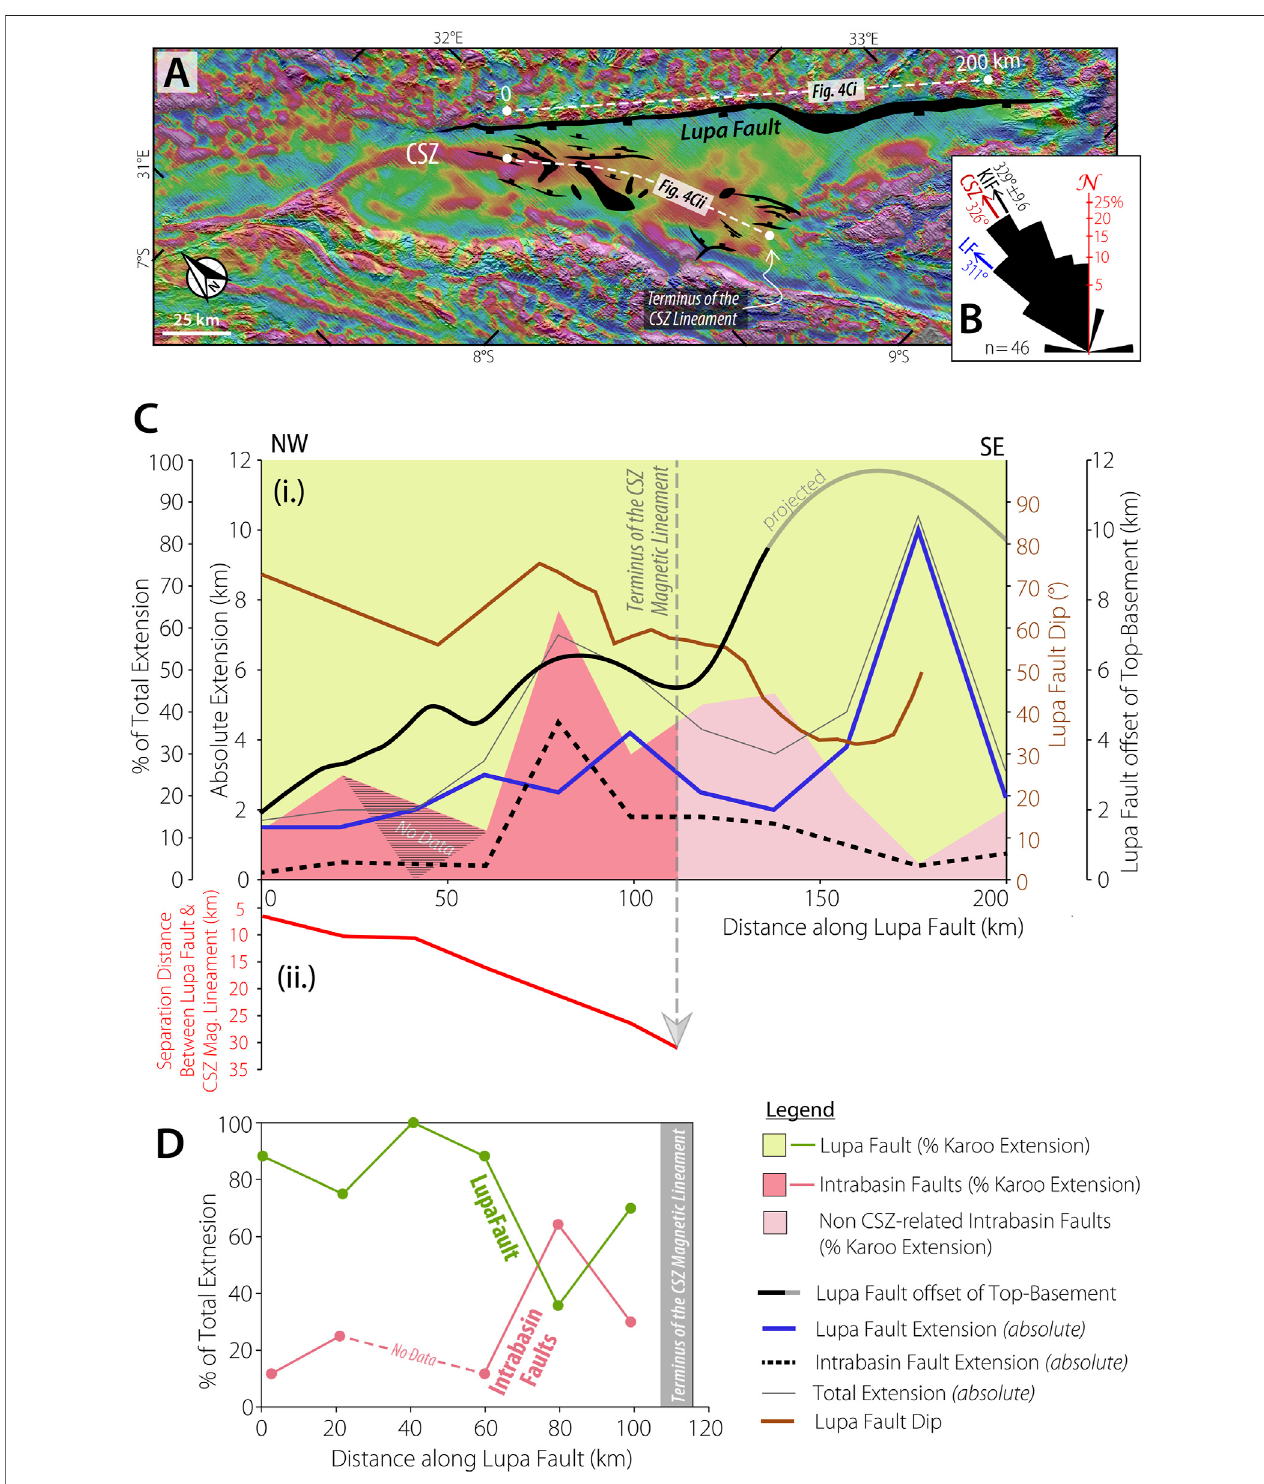
FIGURE 4 | (A) : Map of vertical derivative of the aeromagnetic grid overlaid on satellite DEM hillshade map, showing the section of the Rukwa Rift (white dashed lines) along which, the measurements plotted in Figures 4C,D were taken. (B) : Frequency-azimuth distribution of the Karoo-age intra-basinal faults (KIF; measured in this study). CSZ (cid:1) Chisi Shear Zone, LF (cid:1) Lupa Fault. Arrows represent the mean trend of the associated structure. (C) : Plot showing along-rift distribution of (i.) line- length measurement of the Top-Karoo surface as estimates of Karoo-age tectonic extension (for the Lupa and intra-basinal faults), Lupa Fault dip angle, and Top- BasementoffsetalongtheLupaFault,and (ii.) lateralseparationdistancebetweentheCSZandtheLupaFault. (D) :Plotshowingthealong-riftvariationof%totalKaroo- age extension accommodated by the Lupa Fault and the intra-basinal faults up till the CSZ termination (displayed as stacked area plot in Figure 4C ).